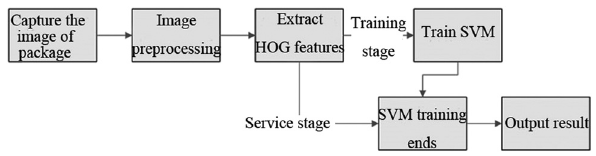
Figure 1: The process of surface defect recognition for the paper